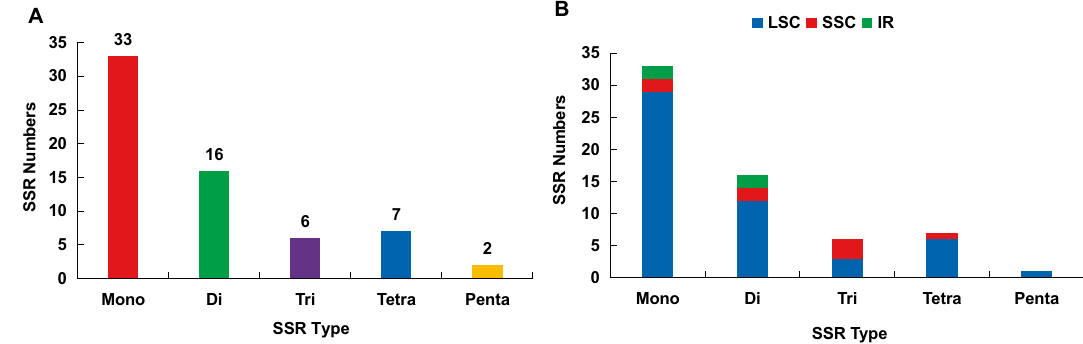
Figure 4. Repeat type and number analysis of SSRs in the chloroplast genome of A. episcopale . ( A ) Simple repeat sequence distribution in the complete cp genome. ( B ) Distribution of SSR in LSC, SSC, and IR regions.